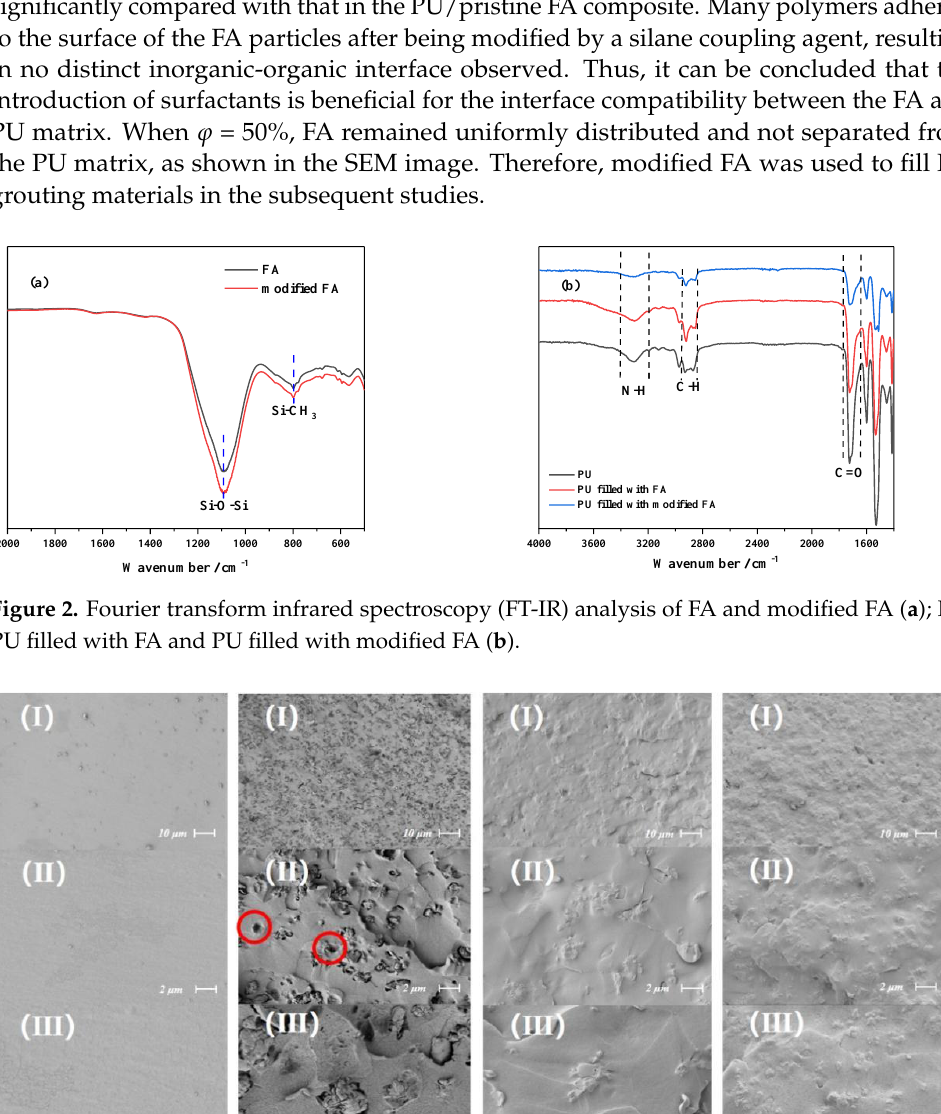
Figure 3. Scanning electron microscopy (SEM) analysis of PU and PU/FA composites: ( a ) PU; ( b ) PU/pristine FA-20%; ( c ) PU/FA-20%; and ( d ) PU/FA-50%.